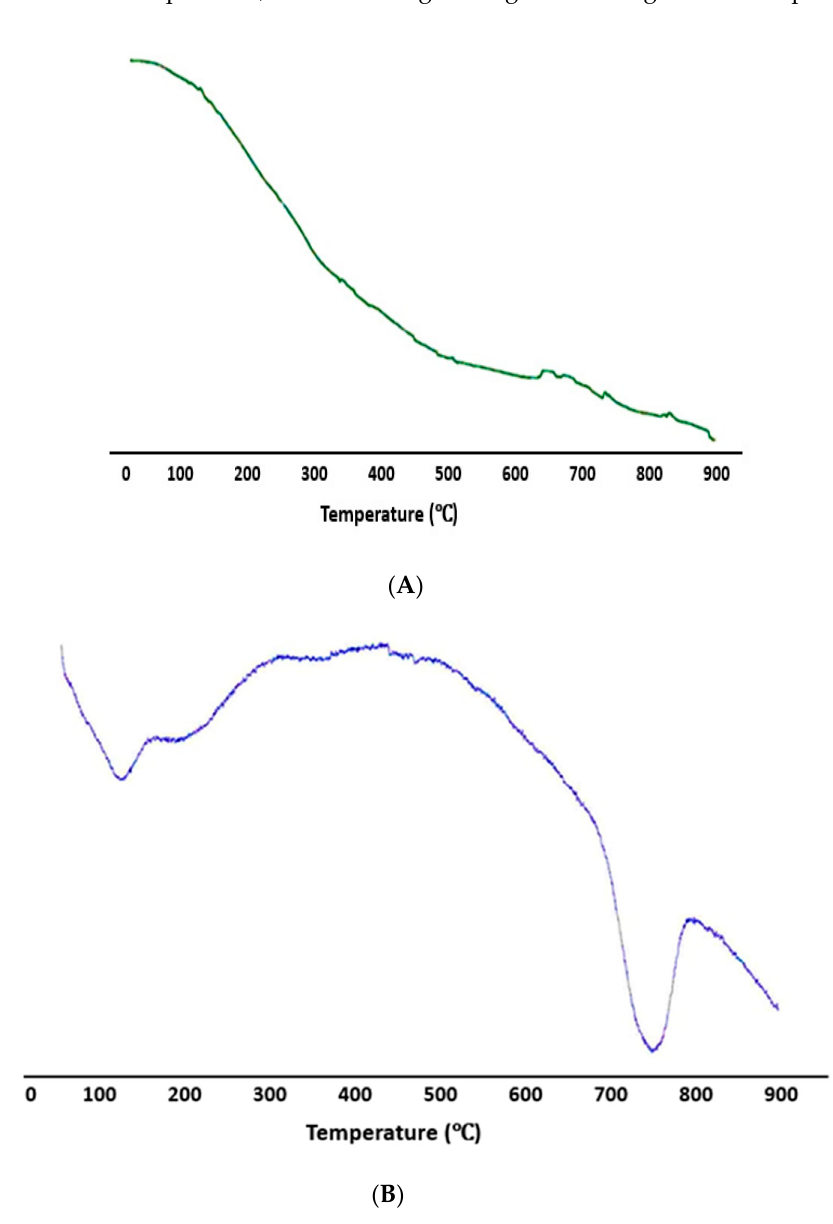
Figure 6. ( A ) Thermogravimetric analysis (TGA) and ( B ) differential scanning calorimetry (DSC) graphs of optimized PrSNPs.